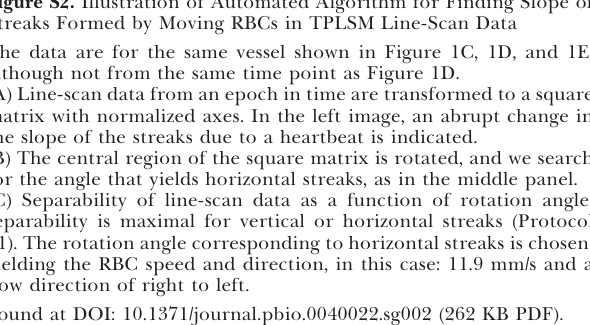
the rat relative to the TPLSM field of view and the CW laser focus. HWP, half-wave plate; PMT, photomultiplier tube. Figure S2. Illustration of Automated Algorithm for Finding Slope of Streaks Formed by Moving RBCs in TPLSM Line-Scan Data The data are for the same vessel shown in Figure 1C, 1D, and 1E, although not from the same time point as Figure 1D. (A) Line-scan data from an epoch in time are transformed to a square matrix with normalized axes. In the left image, an abrupt change in the slope of the streaks due to a heartbeat is indicated. (B) The central region of the square matrix is rotated, and we search for the angle that yields horizontal streaks, as in the middle panel. (C) Separability of line-scan data as a function of rotation angle; separability is maximal for vertical or horizontal streaks (Protocol S1). The rotation angle corresponding to horizontal streaks is chosen, yielding the RBC speed and direction, in this case: 11.9 mm/s and a flow direction of right to left. Found at DOI: 10.1371/journal.pbio.0040022.sg002 (262 KB PDF). Figure S3. Baseline Measurements of the Time-Averaged RBC Speed at the Center of a Vessel as a Function of the Diameter of the Vessel The data include all arterioles in this study. Arterioles measured as part of the photothrombotic (rose bengal) and MCA (filament) occlusion studies are indicated separately. The line represents a best- fit linear regression to the data, and shows a statistically significant correlation, valid for diameters between 10 and 130 l m, between speed, S, and diameter, D, given by S ¼ (4.9 mm/s) þ (124/s) 3 D ( p , 0.0001). Figure S4. Normalized Volume Blood Flux in Five Arterioles as a Function of Time For each vessel, each measurement of the flux was normalized to the average over all measurements for that vessel. The five vessels varied substantially in their average volume flux: 0.17 (circles), 0.013 (diamonds), 0.0048 (squares), and 0.0021 l l/s (triangles). The inset shows the histogram of the normalized flux for all vessels, after the long-term decrease in flux ( ; 5% per h) is removed. Found at DOI: 10.1371/journal.pbio.0040022.sg004 (710 KB PDF). Figure S5. Epi-Fluorescence Images Overlaid on Wide-Field Images Showing Vascular Retention of Circulating Fluorescein-Dextran (A) The brain surface was irradiated with 1 mW of 532-nm irradiation for 1 min after an intravenous injection of rose bengal. The laser focus was deliberately located in a region where there were no surface vessels; therefore no surface vessel was clotted. The vascular retention and parenchymal extravasagation of the fluorescein-conjugated dextran used for in vivo imaging is somewhat more extensive than that observed in Figure 3. This is likely because a surface target vessel was not present to absorb and scatter the incident laser light, leading to a higher fluence incident on the sub-surface capillaries, and increasing the extent of the photochemical damage. (B) A surface vessel was irradiated at 1 mW for 1 min without any rose bengal present. No retention of the fluorescein-dextran is evident in the sub-surface capillaries, indicating no photochemical damage. Figure S6. MAP2 Immunohistology of Coronal Brain Slices beneath a Photothrombotic Clot of a Surface Arteriole (Ischemic Side) and from the Corresponding Location on the Contralateral Side (A, B, E, and F) Clotted side. (C, D, G, and H) Contralateral side. The boxes in panels (A), (C), (E), and (G) indicate the locations of the images in panels (B), (D), (F), and (H), respectively. The arrows in (B) and (F) indicate cells showing minor neuropathology (single arrow indicates cork-screw dendrites; double arrow indicates shrunken cells with eccentric nuclei. Most cells in panels (B) and (F) exhibit no pathology. The example on the left is the same as that shown, in part, in Figure 3. In the example on the right, some trapped RBCs are visible in capillaries beneath the photothrombotically clotted